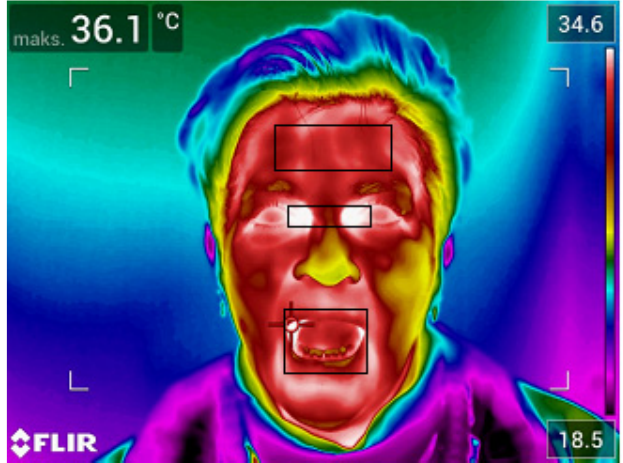
Figure 1. Thermal image of the face made in the anterior-posterior (AP) projection.